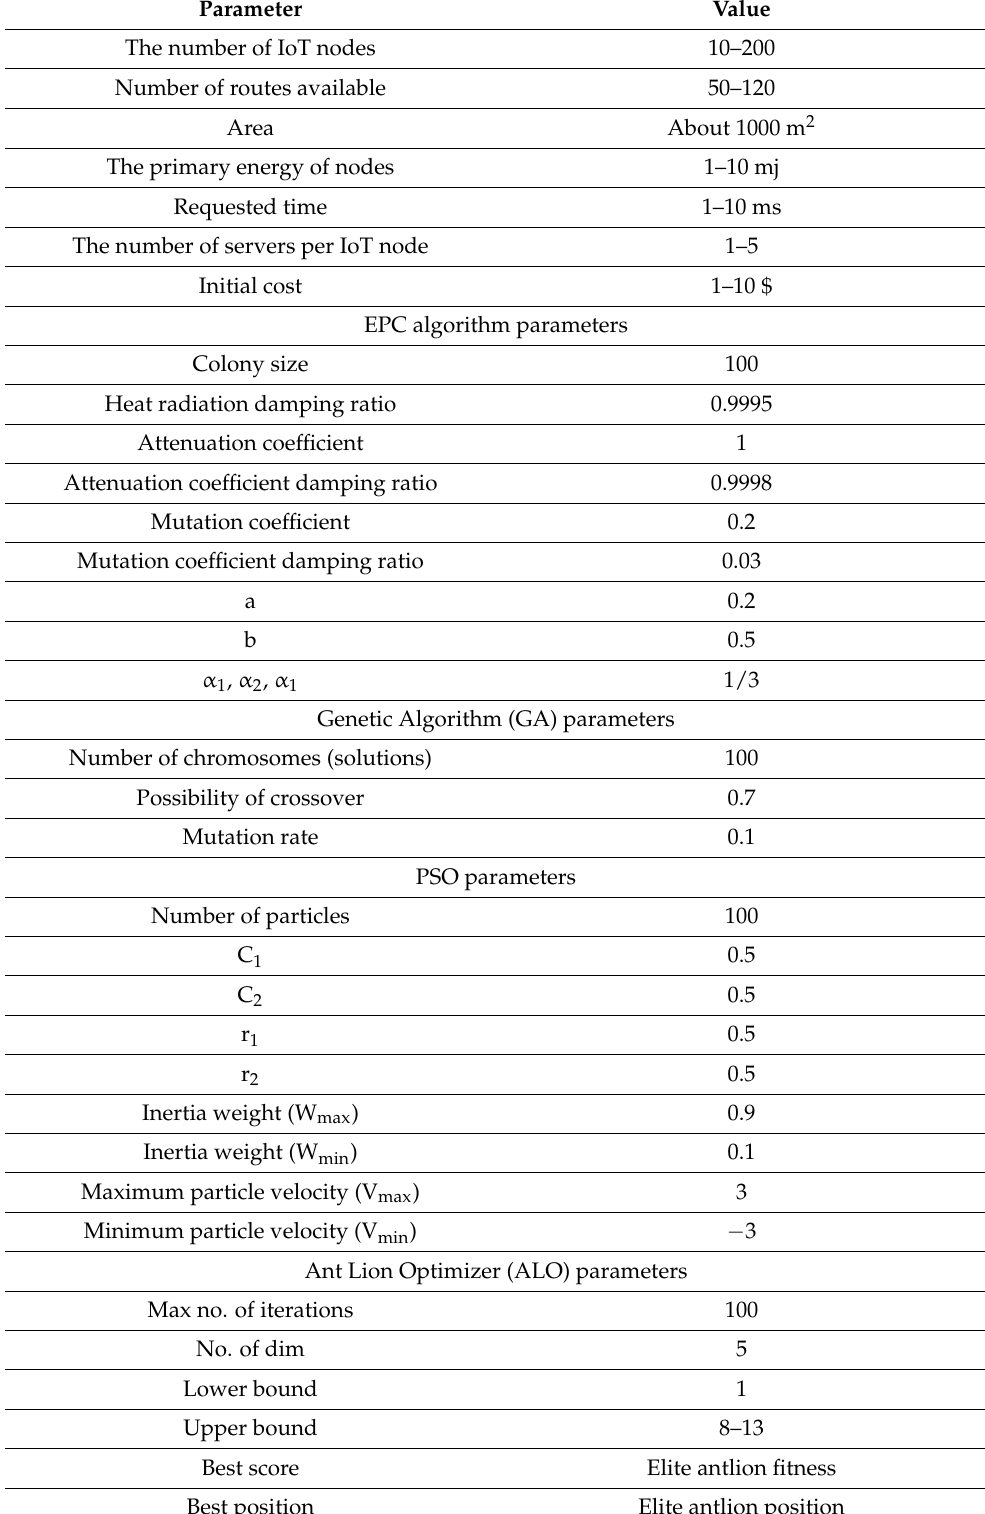
Table 2. Used parameters for the